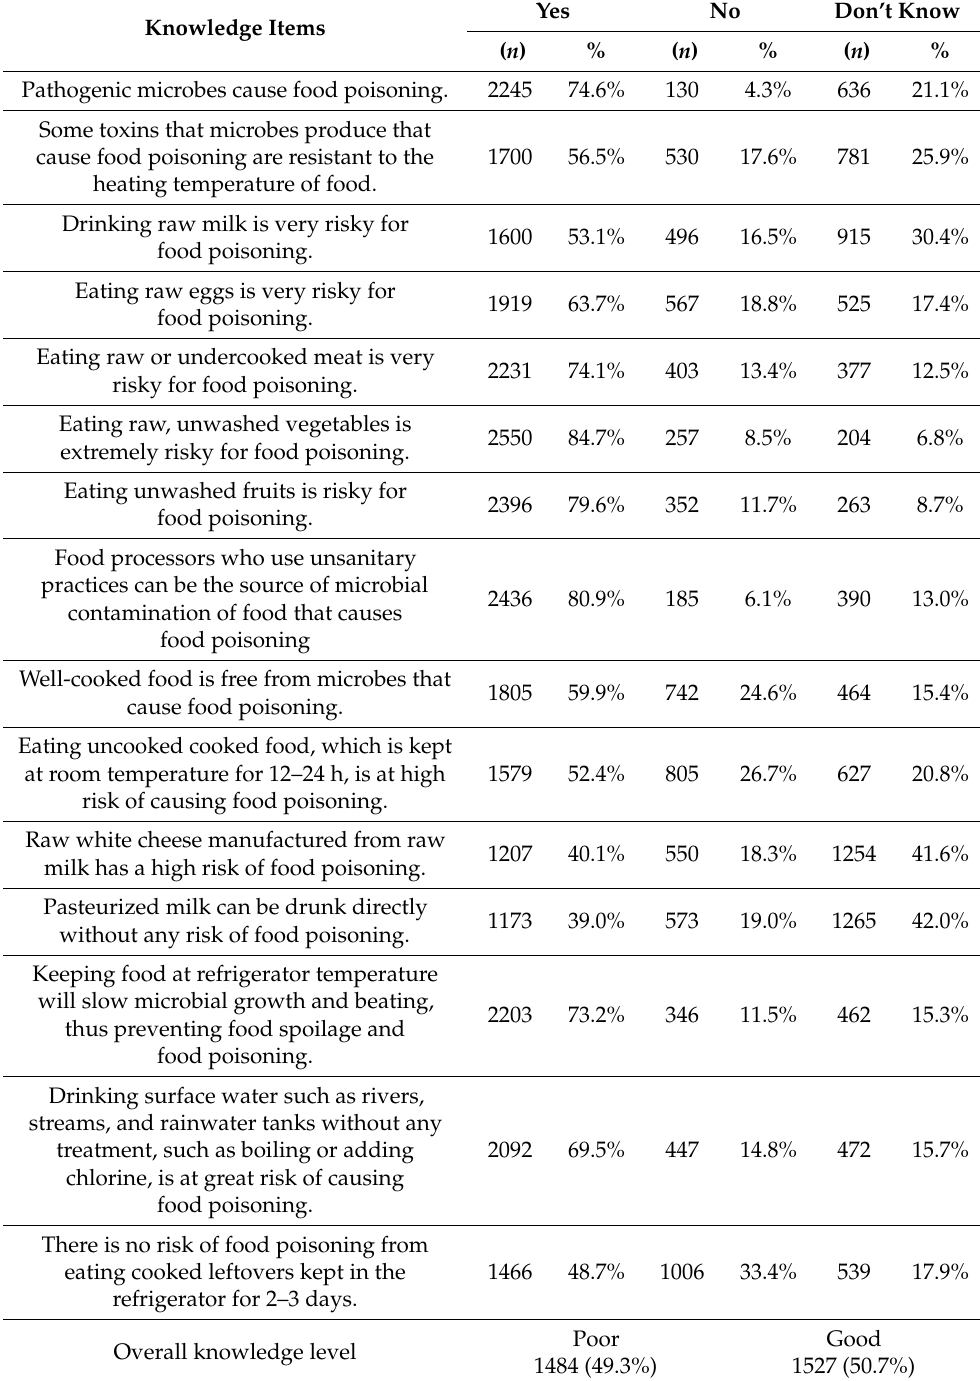
Table 2. Parents’ knowledge regarding food